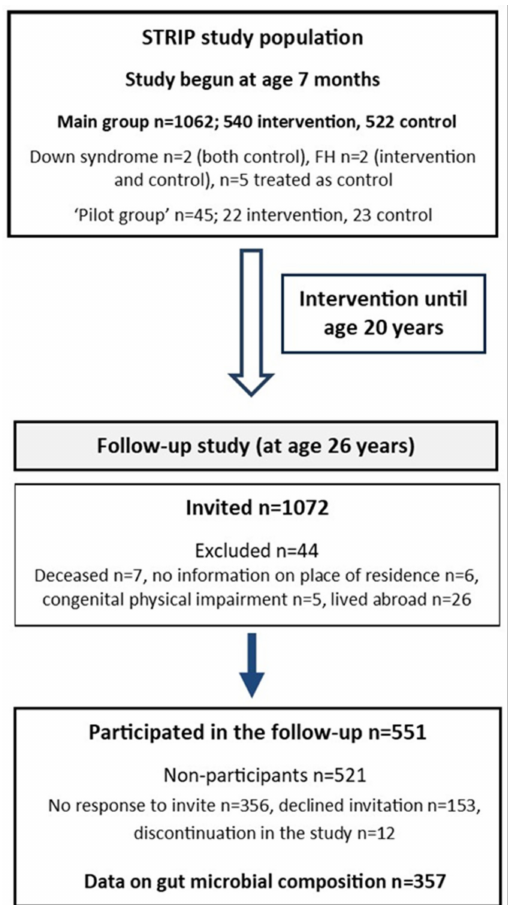
Figure 1. Flow chart of the STRIP study (FH; familial